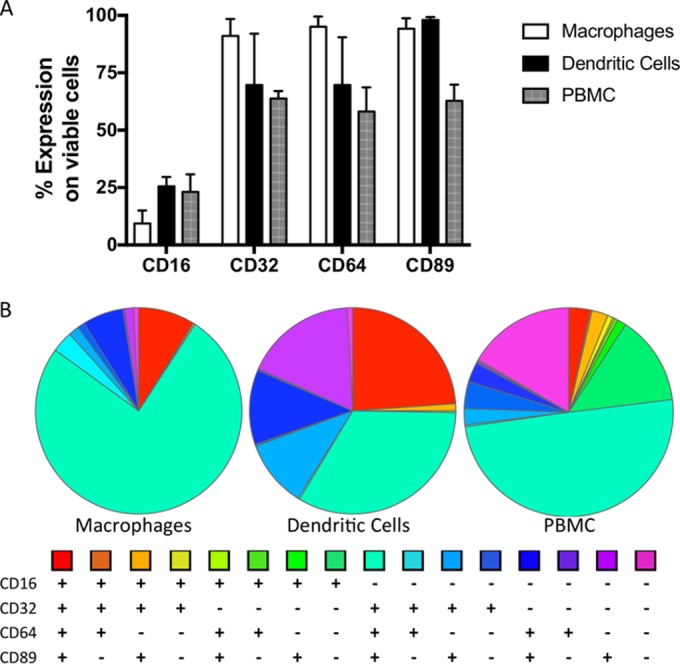
Fc receptor phenotyping of macrophages, dendritic cells, and PBMC used in the cellular inhibition assays. (A) Flow cytometry analysis of the percent expression of CD16, CD32, CD64, and CD89 FcR expression on total viable macrophages, dendritic cells, and PBMC used in the cellular inhibition assays (n = 3). (B) Boolean gating analysis of the FcR expression on total viable cells to show the combinatorial variability of the Fc receptors.